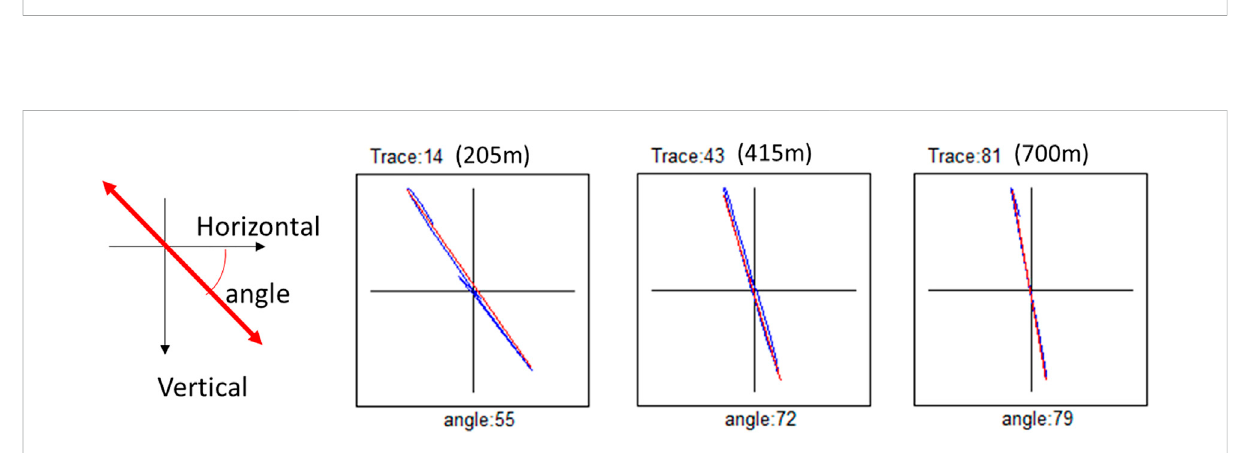
FIGURE 8 EvaluationoftheincidentangleevaluatedbythethreegeophonecomponentswhenthevibratorisshotatSP61.Thelocusisobtainedfromthe time duration of the direct P-wave